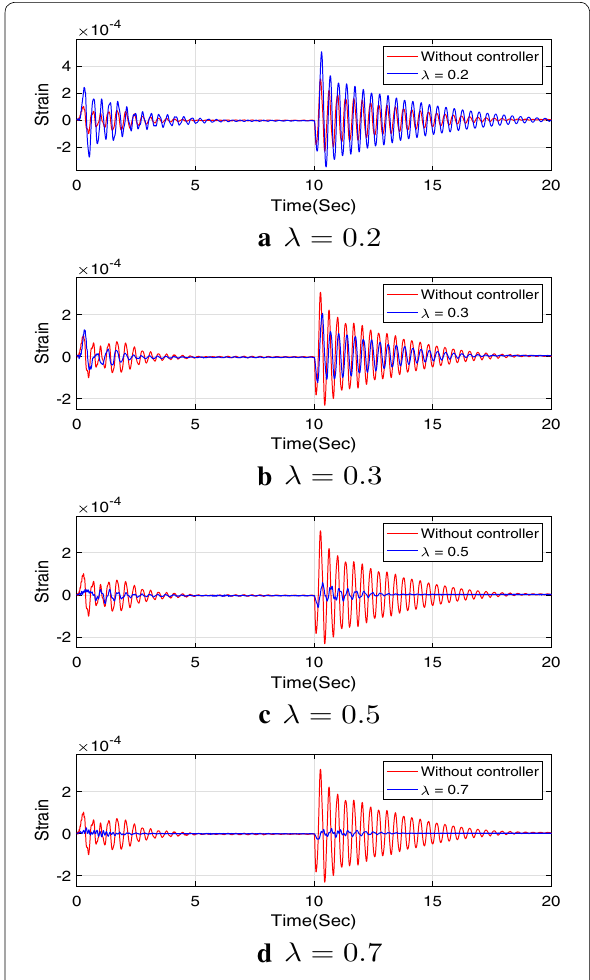
Fig. 13 Link 2 in-plane strain for varying (cid:31) Fig. 14 Link 1 torsional strain for varying